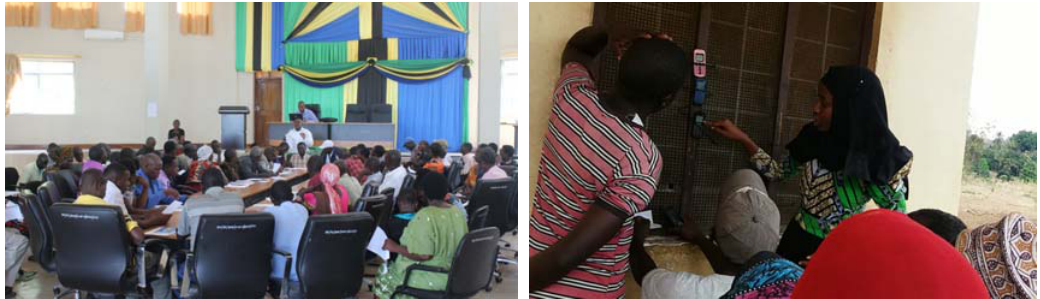
Figure 9. ( Left ) Trainers’ workshop in Bunda in December 2015; and ( Right ) Training of Reporters in Kolero village in Morogoro.